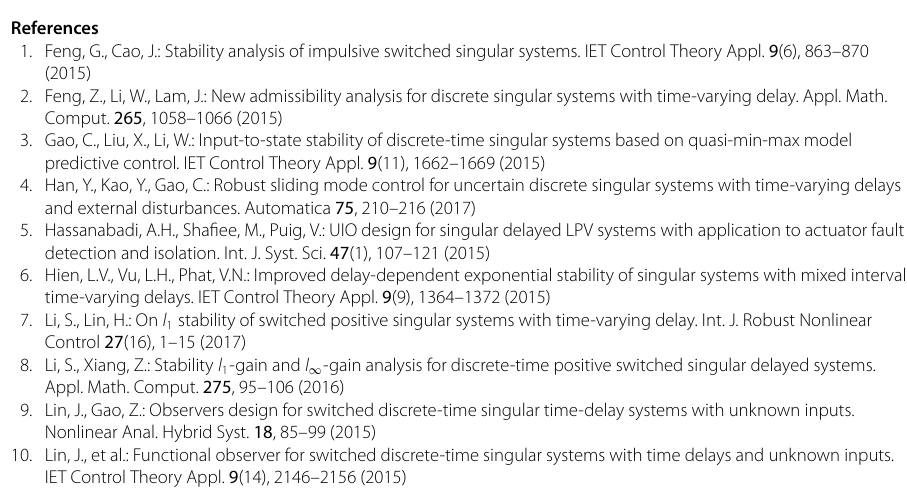
tively. For systems with delay and disturbances, by using the Razumikhin-type technique, we derived exponentially practical stability criteria for a general discrete time system and a linear singular system, respectively. Numerical examples were given to show effectiveness of our theoretical